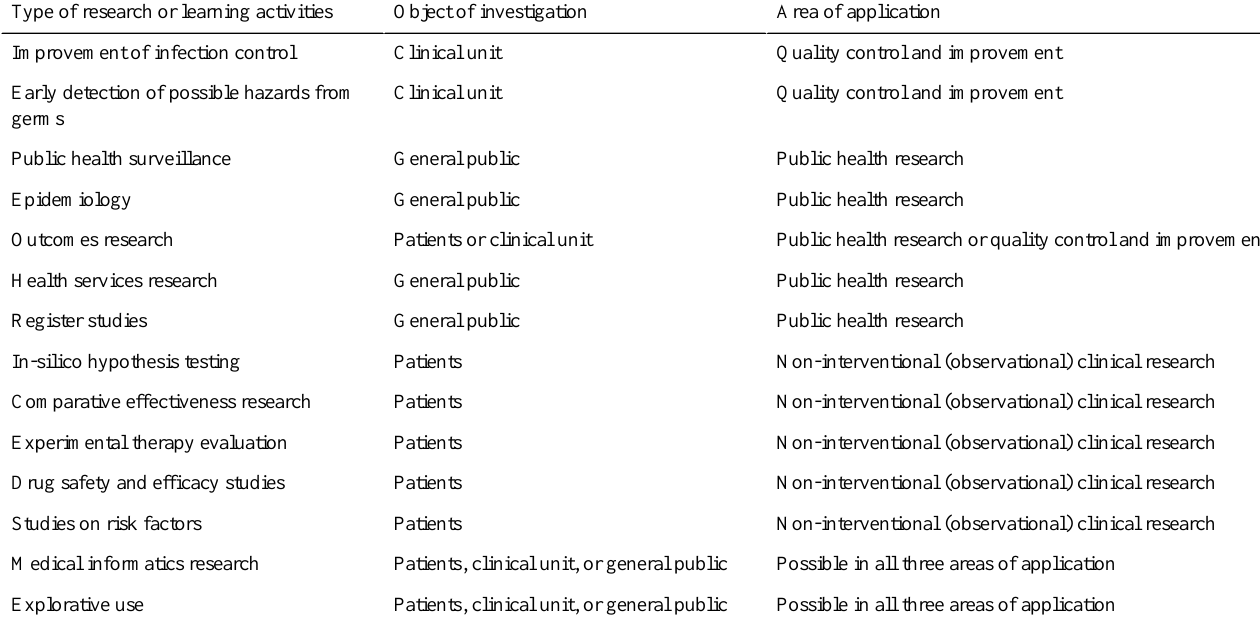
Table 1. Possible types of research or learning activities within secondary use of clinical data in data-gathering, non-interventional research or learning